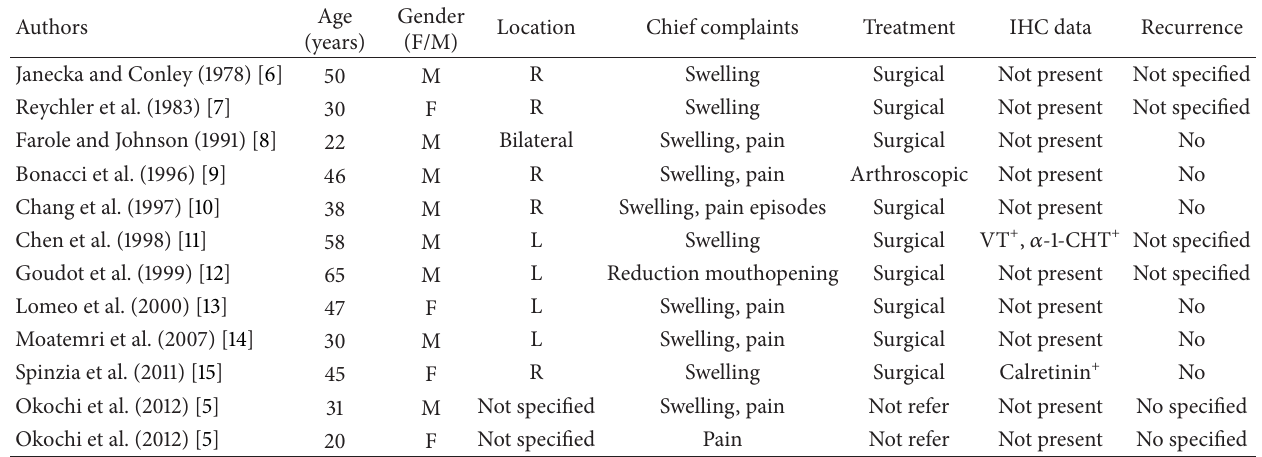
Figure 3: Histologically excised lesion showing a multilocular cyst (a) with fibrous walls. Each of the cystic cavities was lined with a layer of attenuated elongated cells (b), often arranged discontinuously (c) and frequently imperceptible or difficult to recognize (d) (hematoxylin and eosin: 25x, 100x, 250x, and 400x). Table 2: Reported cases of synovial cyst of TMJ in the